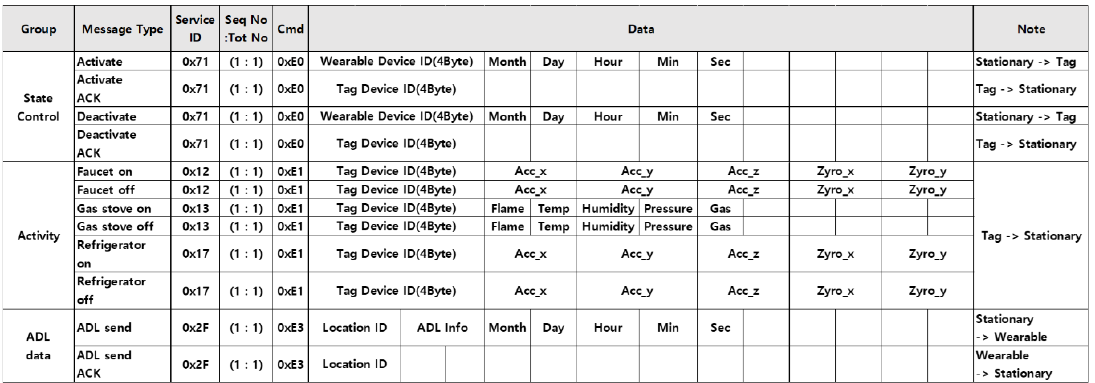
Figure 2. Communication sequence of self-organized device network structure.